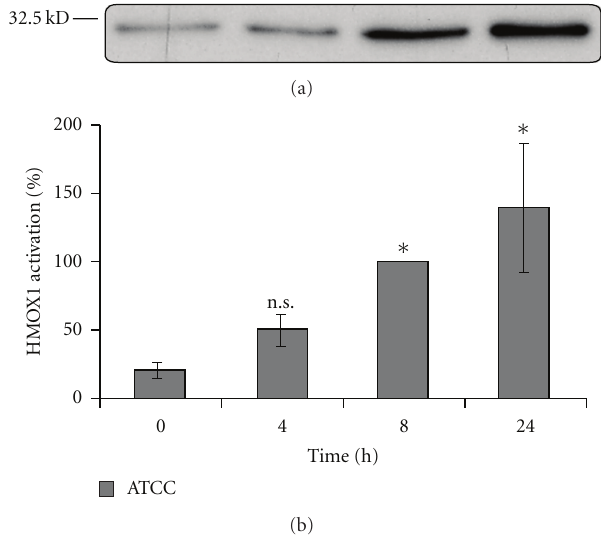
Figure 2: Time course of HMOX-1 upregulation in HCAEC induced by GBS. (a) Autoradiograph of western blot analysis of cell culture lysates demonstrating upregulation of HMOX-1 after 4, 8, and 24 h in comparison to unstimulated HCAEC. (b) Quantitative analysis of the HMOX-1 signaling pathway. Data shown represent mean expression in percent ± SEM of up to 4 independent experiments. The results after 8 hours are defined as 100 percent. ∗ Indicates statistical significant di ff erence ( P < . 05); n.s.: no significant di ff